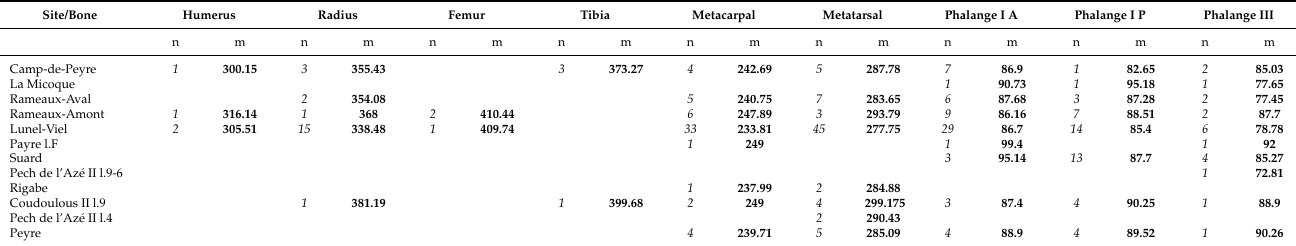
Table 2. Measurements in millimetres of the greatest length of humerus, radius, femur, tibia, metapodials, first anterior phalanges (Phalanges I A), first posterior phalanges (Phalanges I P) and of the greatest width of the third phalange (Phalange III) of caballoid horses of the Middle and Late Pleistocene from France. n = number of specimen; m = mean. Camp-de-Peyre: E. m. campdepeyri ; La Micoque: E. mosbachensis ; Rameaux-Aval and Amont: E. mosbachensis ; Lunel-Viel: E. m. palustris ; Payre l.F: E. mosbachensis ; Suard: E. caballus piveteaui ; Pech de l’Az é II l.9-6: E. mosbachensis ; Rigabe: E. m. palustris ; Coudoulous II l.9: E. mosbachensis ; Pech de l’Az é II l.4: E. caballus ; Peyre: E. caballus